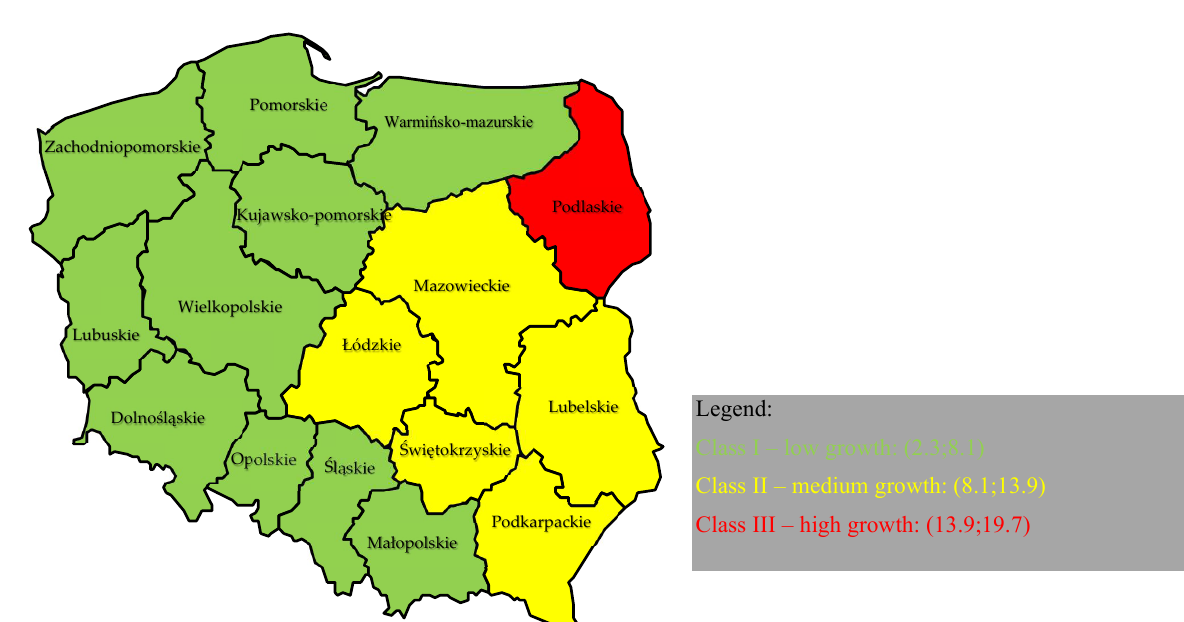
Figure 7. Regional variation in electricity consumption in rural areas of Poland in the years 2004–2019 according to mean annual rate of changes. Source: authors’ study based on Table 3. Table 5. The degree of similarity and concentration of electricity consumption. Year Concentration Similarity Rural Areas Urban Areas Rural Areas Urban Areas